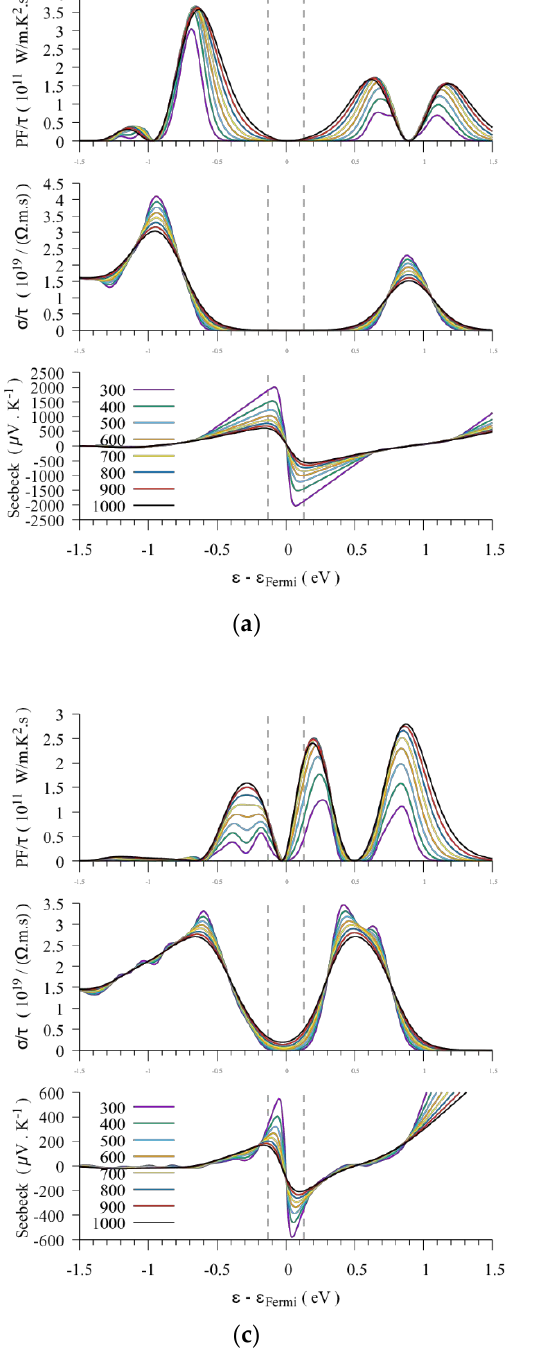
Figure 4. Thermoelectric properties of ( a ) BaRh 2 Ge 4 S 6, ( b ) BaRh 2 Ge 4 Se 6 and ( c ) BaRh 2 Ge 4 Te 6 , from 300 to 1000 K. Bottom: Seebeck coefficient; middle: electrical conductivity; top: power factor. The dashed vertical lines delineate the energy 5 k B T around the Fermi level.